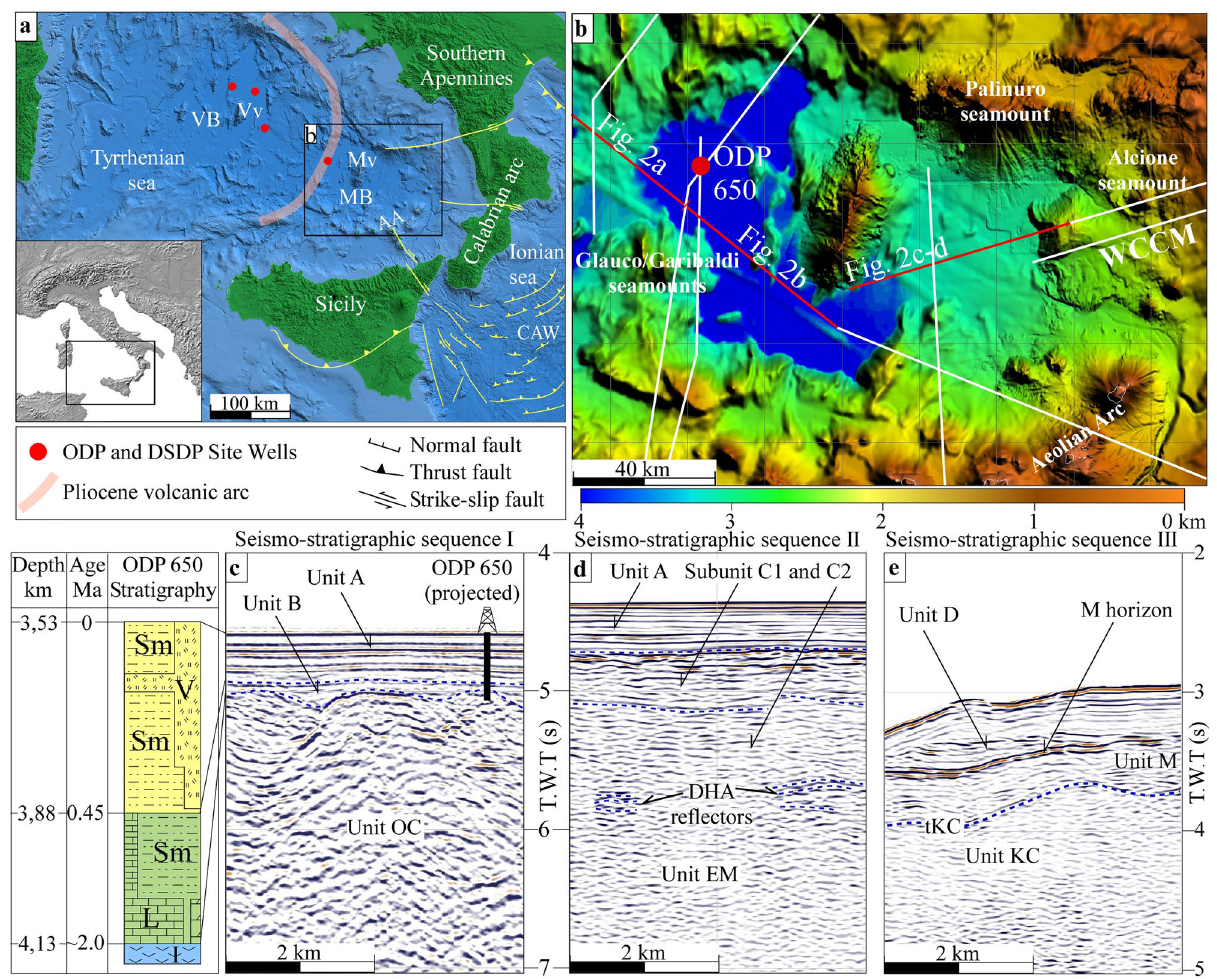
Figure 1. ( a ) Schematic tectonic map of the Tyrrhenian ‐ Ionian subduction system. AA: Aelonian Arc, CAW: Calabrian accretionary wedge, MB: Marsili basin, Mv: Marsili volcano VB: Vavilov basin, Vv: Vavilov volcano. Inset shows the location of the area. ( b ) Morphobathymetric map of the Marsili basin and surroundings. WCCM: western Calabrian continental margin. Red point indicates the location of the ODP 650 site well. Red and white lines are the traces of the seismic profiles used in this study. Red lines are the parts of the profiles shown in Fig. 2. The map was generated using the GeoSuite AllWorks software package (version 2021R2, https:// www. geoma rines urvey syste ms. com/ downl oads/). ( c , d , and e ) Seismo-stratigraphic sequences I, II and III recognised on seismic profiles. T.W.T.: two ‐ way travel. Location of box c is displayed in Fig. 2a, and location of boxes d and e in Fig. 2c. Box c also shows the stratigraphic scheme of the units recognised on the ODP 650 site and their correlation with the seismo-stratigraphic units of sequence I. Sm: sandy mud, V: volcanoclastic rocks, L: limestone, I: igneous rocks. Correlation between seismic units and stratigraphy is based on seismic facies analysis and stratigraphic data from ODP Site transition towards the oceanic crust 21 . In the Tyrrhenian basin, backarc extension led to moderate lithospheric and crustal thinning along the basin margins and two spreading centres, ca. 80 km apart, the Vavilov (4.3–4.1 to 2.6 Ma) and Marsili basins (Late (?) Pliocene to ~ 1.87 Ma) 20 . Crustal thinning also produced mantle exhu- mation, magmatic accretion (Magnaghi and Vavilov basins) 22 and intrusion of mid-ocean ridge basalts 23 . OIB- MORB type basalts and Island Arc Basalts (IAB) formed in the Vavilov and Marsili basins, respectively 24 . The area between the Vavilov and Marsili basin hosts several volcanic seamounts (smt) representing a former Pliocene volcanic arc 25 (Fig. 1a). The volcanic arc extends in the central Tyrrhenian Sea and includes the Anchise smt (5.2–3.6 Ma) 25 in the south, the Glauco-Garibaldi smt in the centre, and the Pontine Islands (4.2–0.1 Ma) 26 and buried calc-alkaline rocks of the Campanian Plain in the north 25,27,28 . The Marsili volcano is a NNE-SSW elongated ridge located in the central part of the Marsili basin, and elevated ~ 3000 m from the abyssal plain (Fig. 1a and b). Rocks samples recovered from the Marsili volcano indicate that it is mainly composed of medium-K calc-alkaline basalts. High- evolved K andesites rocks samples were only retrieved from small cones on the summit axis zone 29 . The Marsili volcano has been interpreted as the spreading ridge of the Marsili backarc basin 18,19,30,31 or a superinflated ridge 32 .